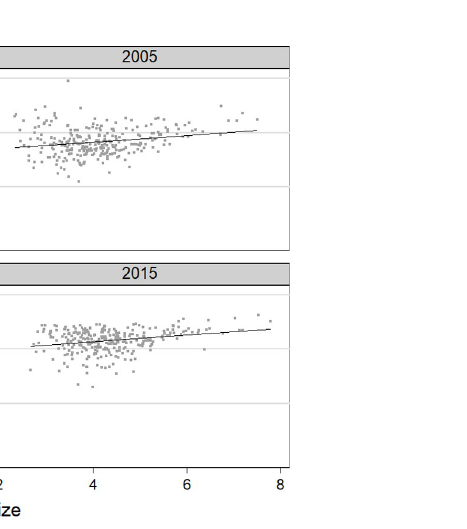
employment ratio in the decade after the base year (2005) was negatively correlated with the high-skill employment ratio in the base year. This implies that the ratio of high-skilled